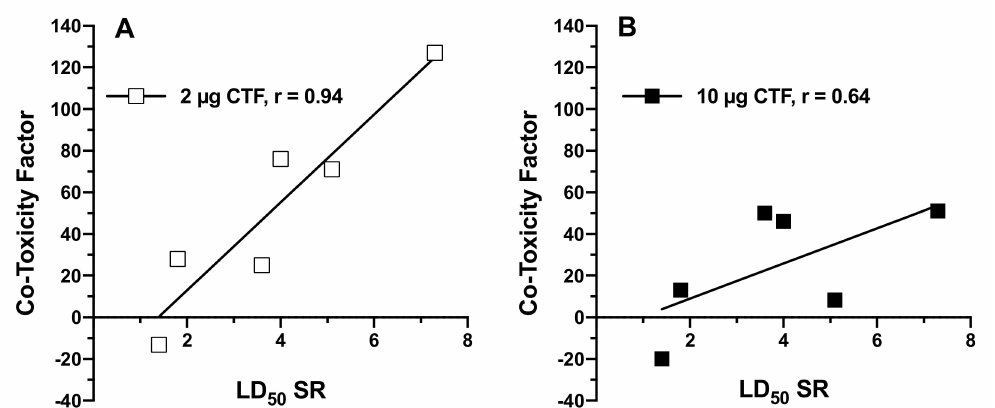
Figure 1. Synergism ratios of LD 50 values (SR) plotted against co-toxicity factors (CTF) obtained at ( A ) 2 µ g/insect and ( B ) 10 µ g/insect, along with linear regression analysis. Strong linear correlation value was observed for the 2 µ g/insect (Pearson’s correlation coefficient r = 0.94), whereas at 10 µ g/insect moderate linear correlation was observed (Pearson’s correlation coefficient r =